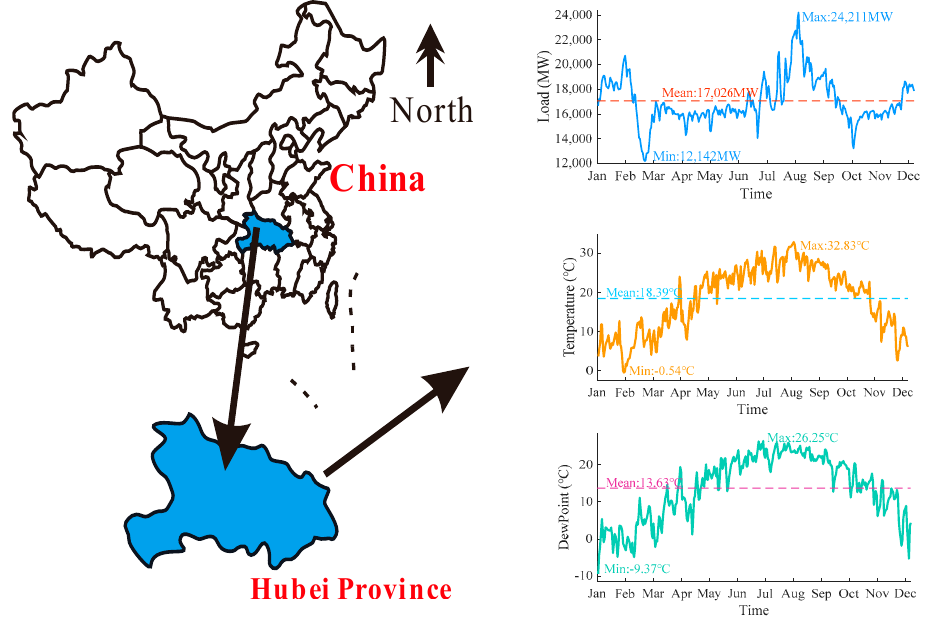
Figure 4. Environmental variables and load in the Hubei Province.